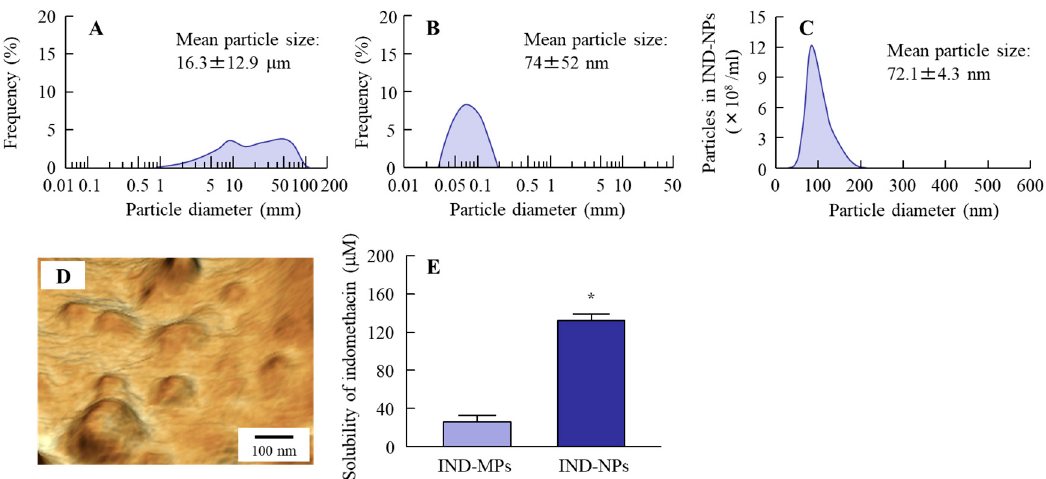
Figure 1. Changes in particle size frequencies and solubility of indomethacin in indomethacin nanoparticles (IND-NPs). ( A ) Particle size frequencies of indomethacin in IND-MPs; ( B – E ) Particle size frequencies ( B , C ), atomic force microscope (AFM) image ( D ), and solubility ( E ) of indomethacin in IND-NPs. Data of Figure 1A,B were obtained by a laser diffraction particle size analyzer, and Figure 1C was measured using the dynamic light-scattering method. Figure 1D was observed by SPM-9700. n = 5. * P < 0.05 vs. IND-MPs. The particle size of indomethacin in IND-NPs was 50–200 nm, and 90.6% of indomethacin in the IND-NPs was of solid type (not dissolved type).